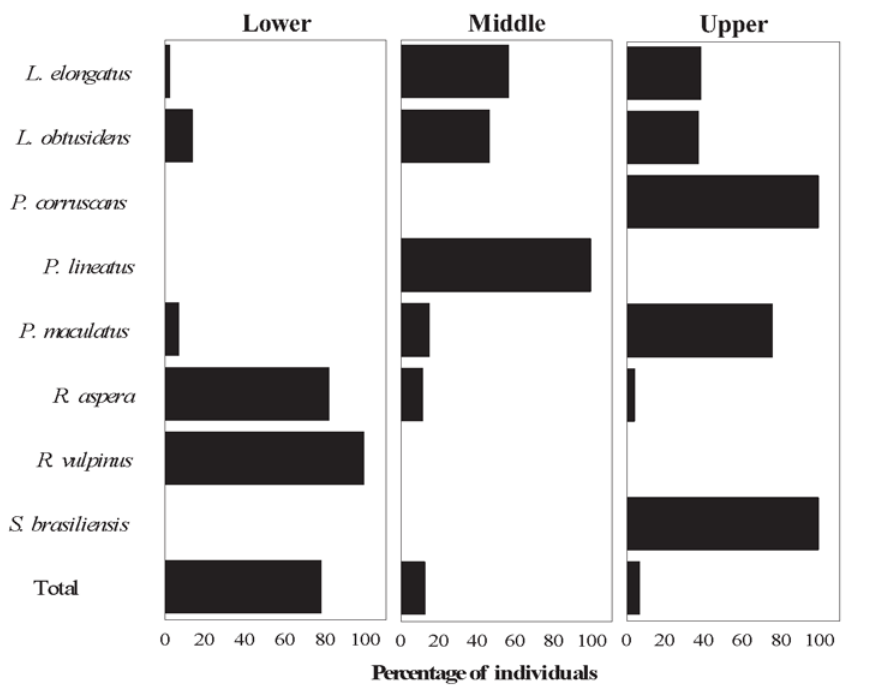
Fig. 5. Percentage of individuals of migratory species in the pools sampled in the ladder located at Engenheiro Sergio Motta Dam.